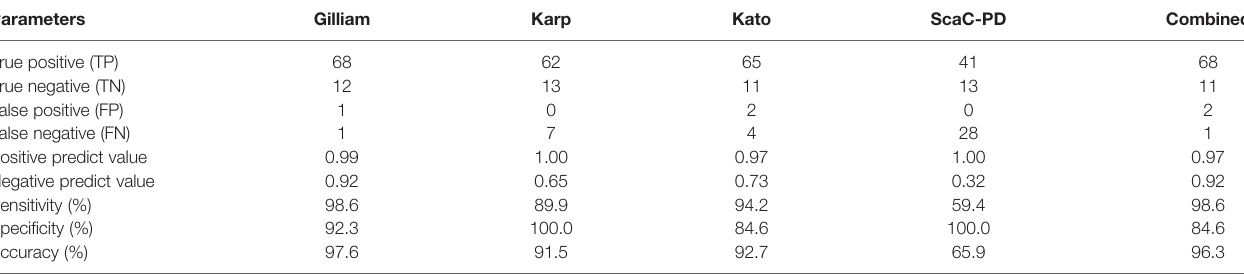
TABLE 3 | Detection ef fi ciency of our cell-based ELISA system with individual or combined antigens for the 69 positive and 13 negative serum samples. Parameters